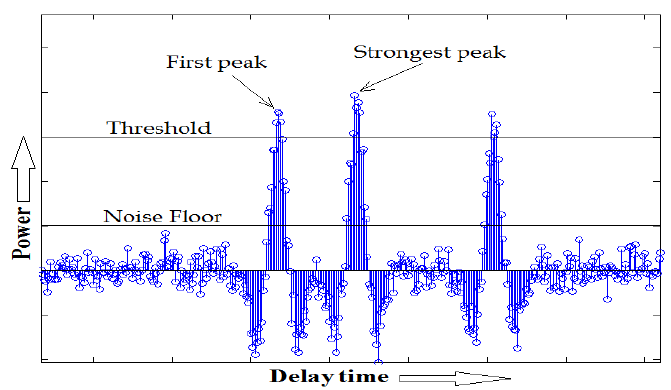
Figure 4. Search-back detection